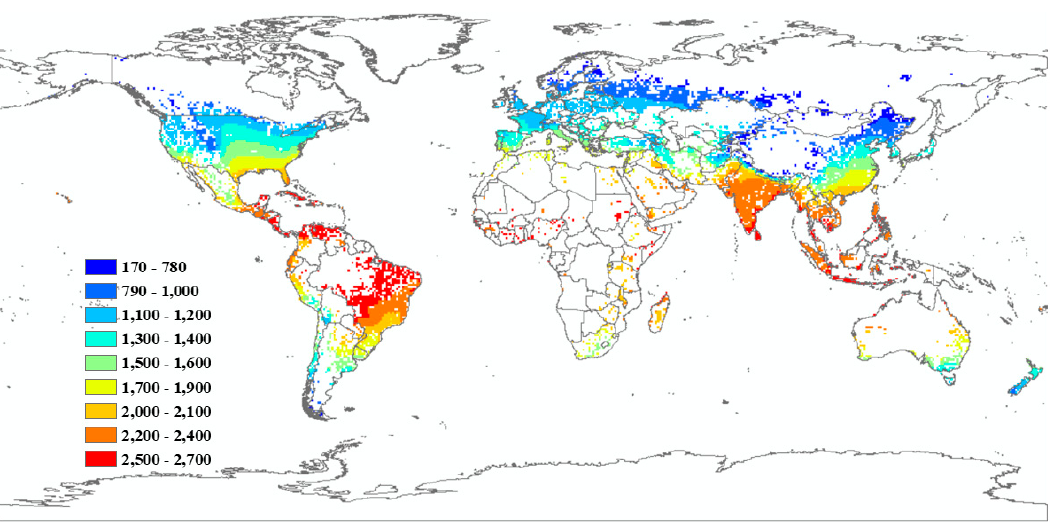
Figure 12. Net irrigation water requirement of NCAR model in 2050 (RCP8.5). The same irrigated area than in 1960 is used the same in Figure 1.